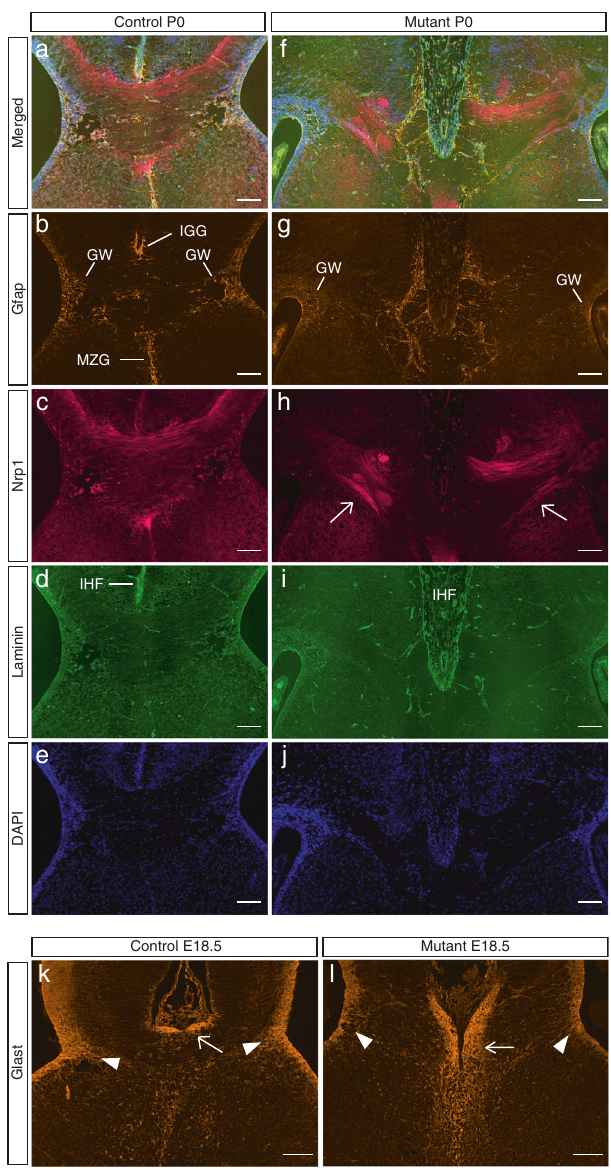
Fig. 3 Aberrant midline glia in mutant mice. a – j Immunostainings of P0 coronal brain sections: Neuropilin 1-positive cortical axons fail to cross horizontally in mutant animals. Instead, some axon bundles deviate ventrally at the ipsilateral side (arrows in h ). Gfap-positive midline glia are aberrantly positioned and the glial wedge population is diminished in the mutant brain ( g ) GW glial wedge, IGG indusium griseum glia, MZG midline zipper glia. A widened interhemispheric fi ssure (IHF, laminin-positive connective tissue cells and basement membranes are stained in d and i ) that is not crossed by cortical axons is present in the mutant brain. k , l Immunostainings of E18.5 coronal brain sections with an anti-Glast antibody (red immunosignals). The Glast-positive radial glial population at the position of the prospective Gfap- positive GW is reduced and shows shorter radial processes (arrowheads in k , l ). Glast-positive immunosignals above the developing corpus callosum are horizontally positioned in the control brain (arrow in k ) but deviate toward the midline in the mutant brain (arrow in l ). All scale bars: 100 µ